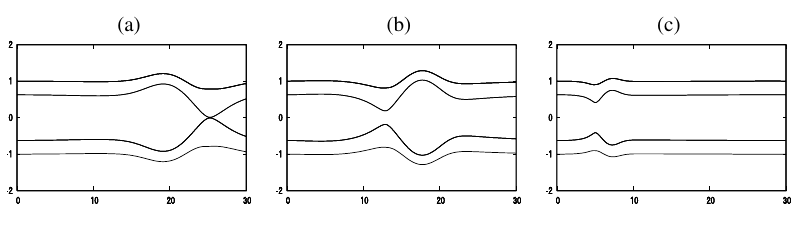
Fig. 10 Breakup profiles of the jet for the parameters in a gas-cored liquid jet experiment of Kendall (4) , where Wb = 32 . 5, σ = 1, ρ = 0 . 001, ¯ u 2 = 1 and ¯ b = 0 . 375; (a) ¯ u = 1 . 4 at t = 22 . 55, (b) ¯ u = 4 . 2 at t = 18 . 60, (c)¯ u = 12 . 6 at 1 1 1 t = 8 .